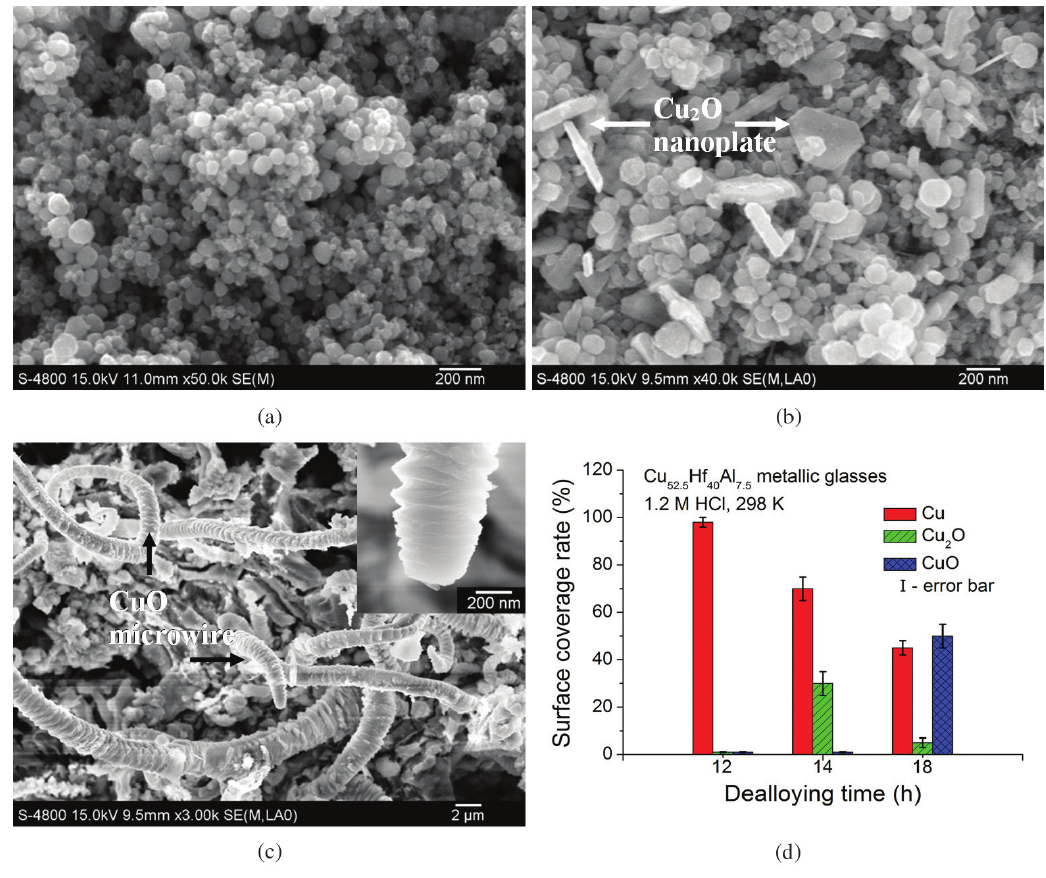
Figure 3. SEM images of the Cu Hf Al metallic glasses etched in 1.2 M HCl solution at 298 K for (a) 12 h, (b) 14 h, (c) 18 h, the 52.5 40 7.5 inset shows the microwire image at a higher magnification. (d) Surface coverage rate of different corrosion products with dealloying